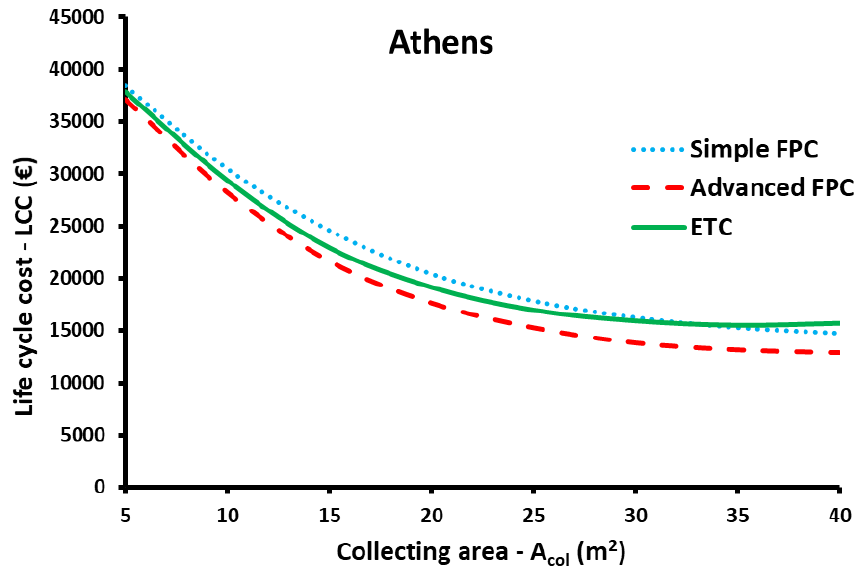
Figure 20. Life cycle cost for different collecting areas and collector types for Athens.